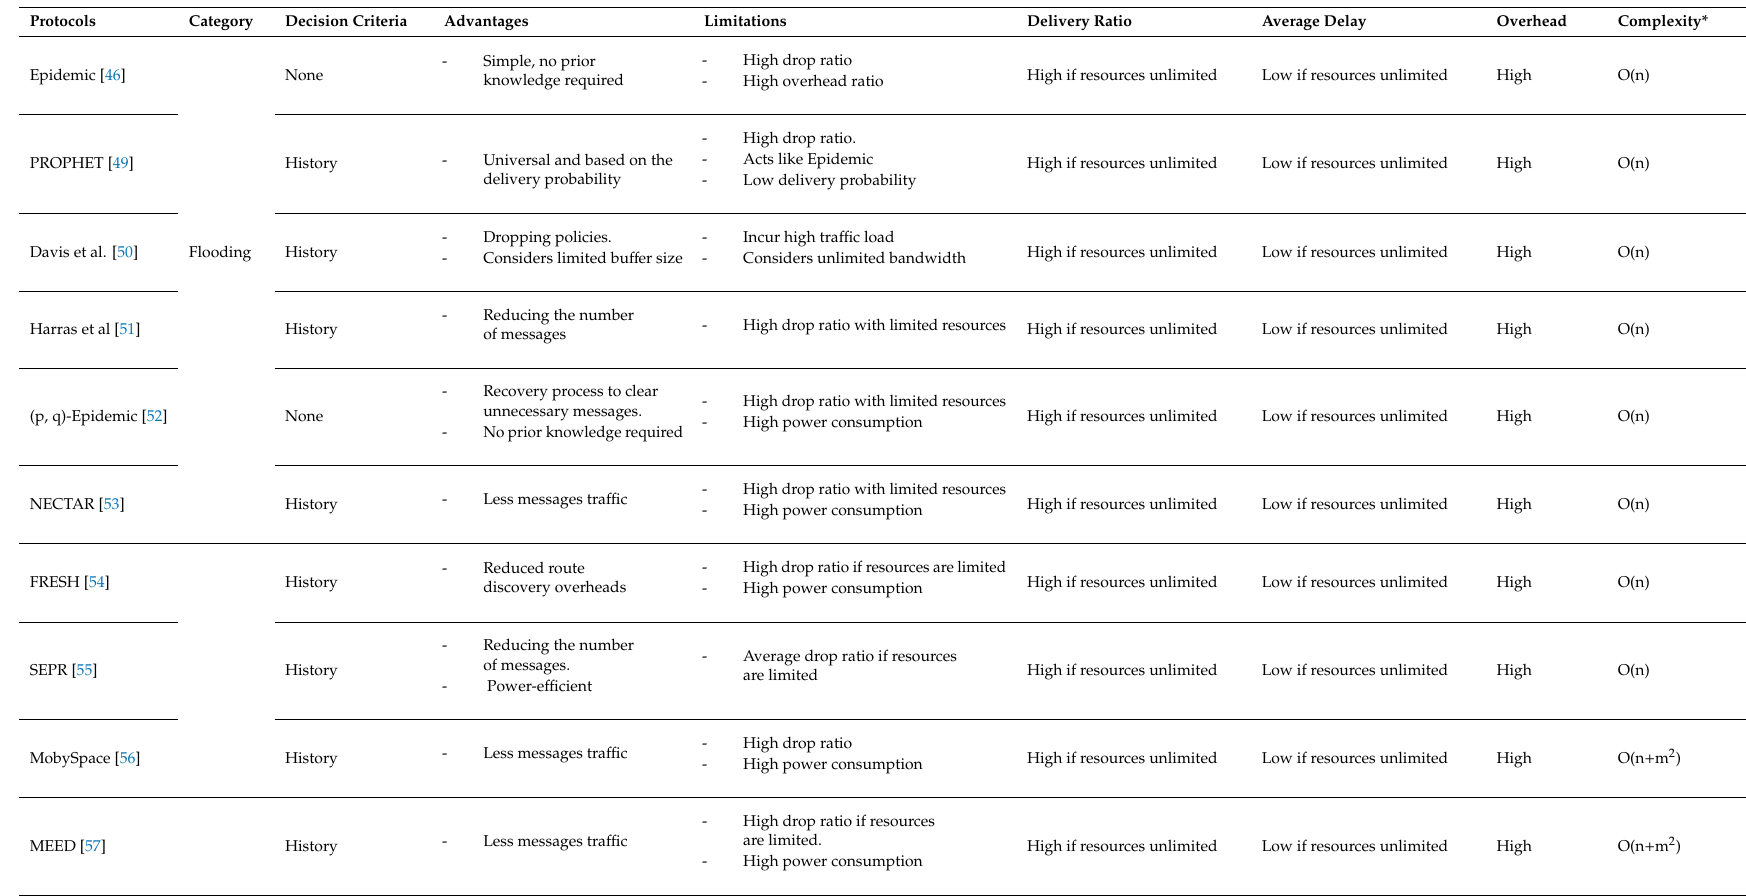
Table 4. Delay tolerant network routing